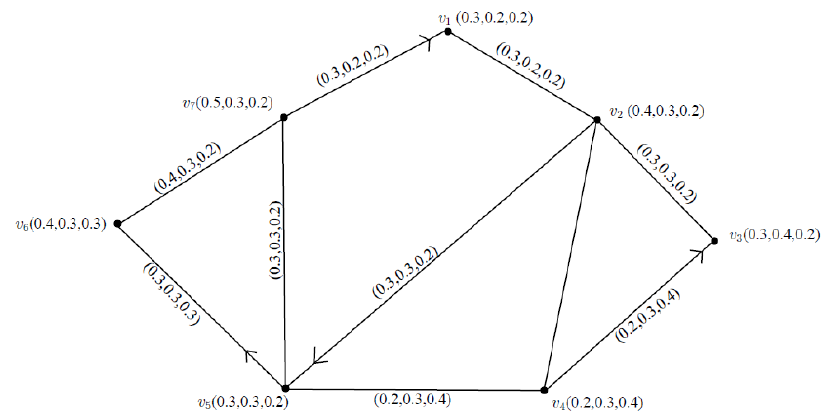
Figure 1: Mixed Picture Fuzzy